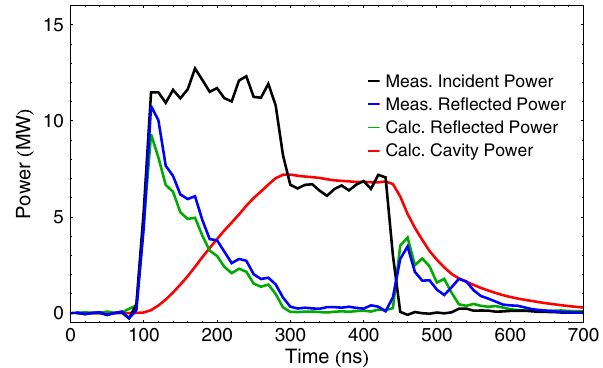
FIG. 13. Sample traces from the peak power meter for a 150 ns pulse at a gradient of 126 MV = m . The incident and reflected power measured by the peak power meter are shown in black and blue, respectively. The calculated reflected power and power coupled intothe structure are shown in green and red, respectively.